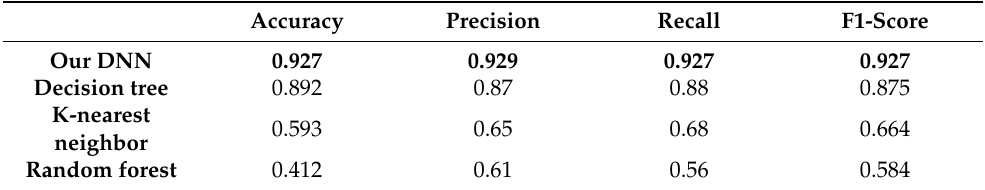
Table 10. Per-class precision, recall, and F1-scores. Comparison between our proposed DNN and other traditional machine learning